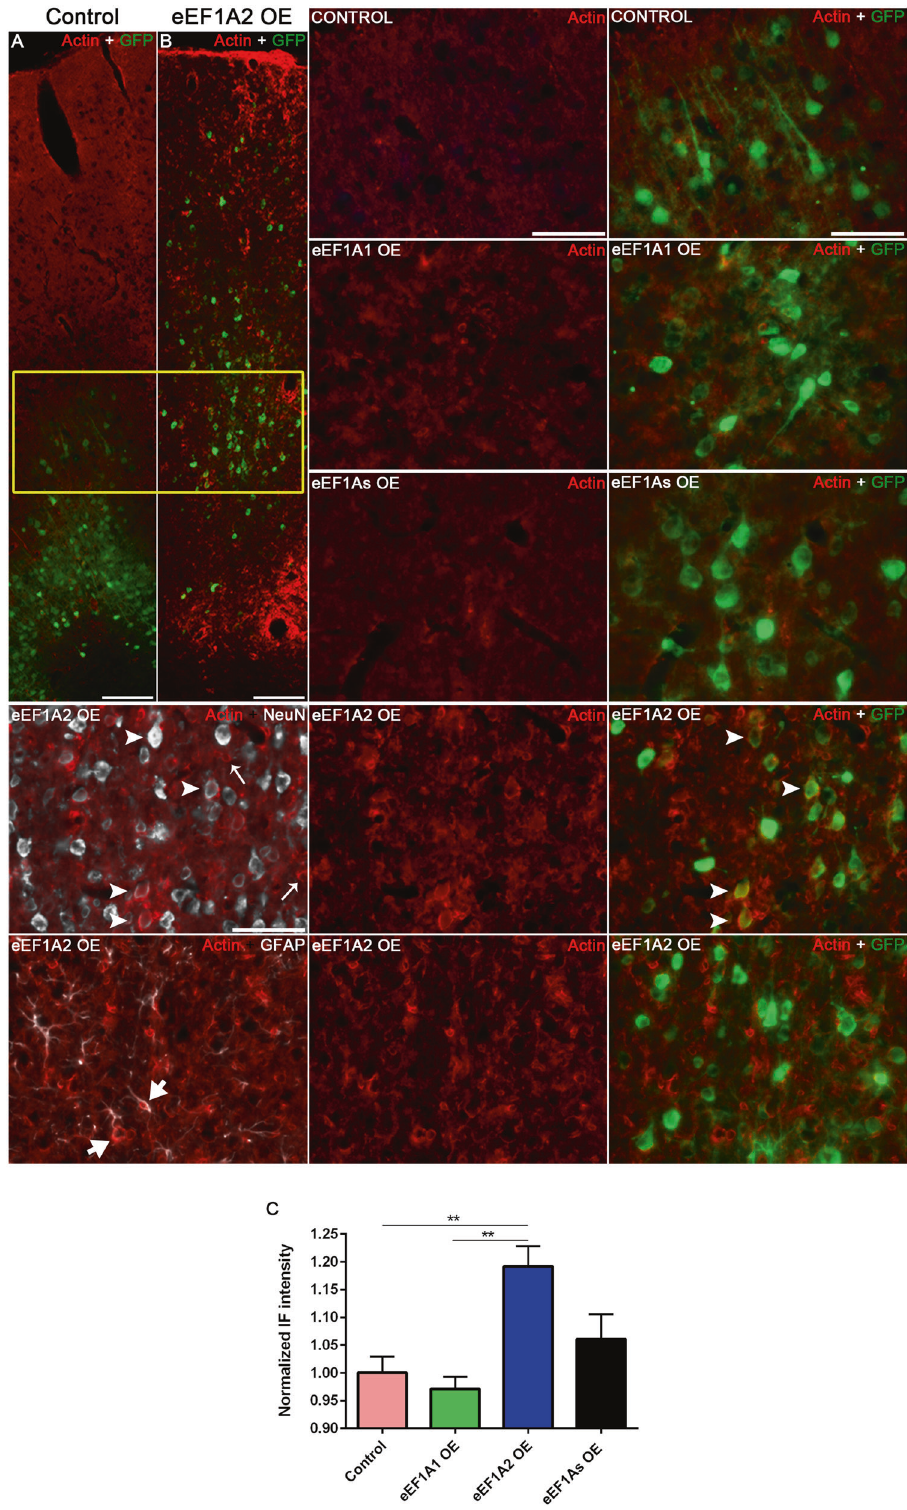
Fig. 5 Only eEF1A2 OE mice display actin rearrangement. Left panels: Representative 10× images of β -actin and GFP (viruses) staining at the right sensorimotor cortex of in control ( A ) and eEF1A2 OE ( B ) mice. Right and bottom panels: Detail from the cortical layer V (yellow box) at 20× magni fi cation. Please note the bundled pattern of β -actin staining de fi ning the cellular shape in NeuN + cells (arrowheads), GFP - /GFAP + cells (thick arrows), and GFP - /GFAP - /NeuN - cells (thin arrows). Scale bars = 50 µm. C Quanti fi cation of β -actin immunoreactivity in cortical layer V. 3 mice per genetic condition. Stats: Ordinary one-way ANOVA. Bars show mean ± SEM. ** p = 0.0054, Control vs eEF1A2 OE; ** p = 0.0018, eEF1A1 OE vs eEF1A2 OE.